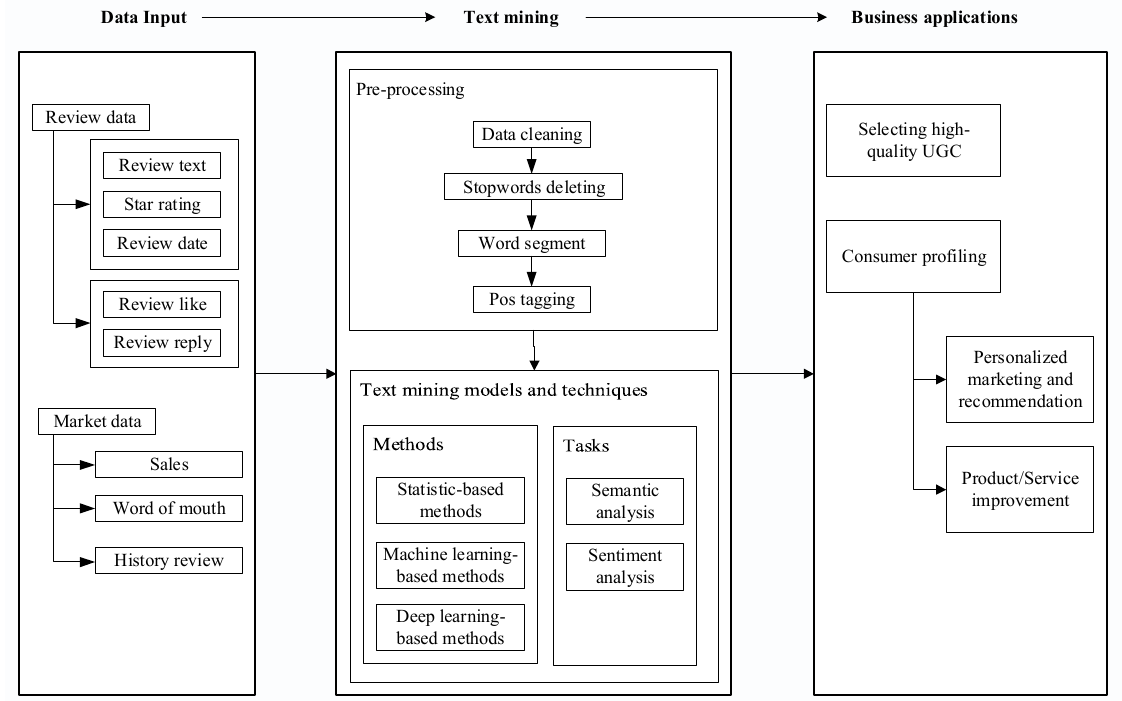
Figure 2. The general research framework.